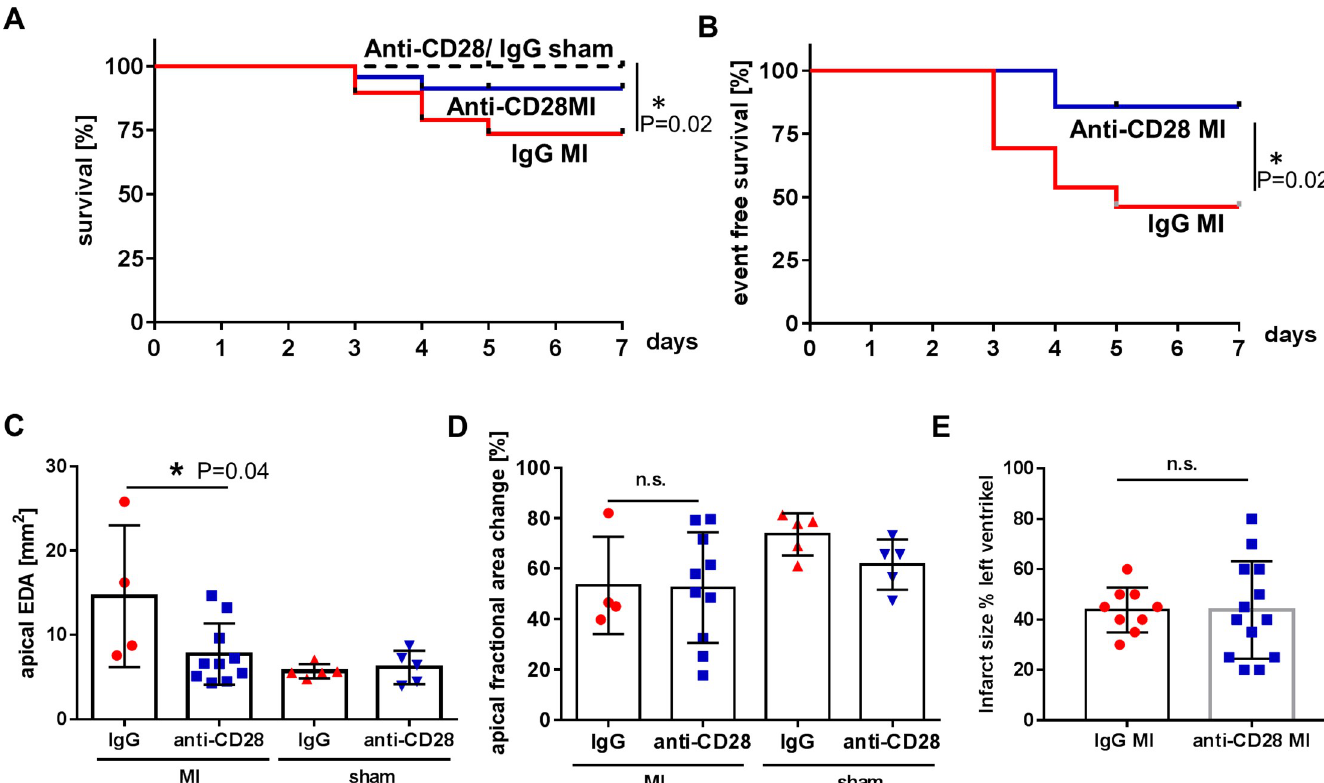
Fig 2. Treatment with anti-CD28 mAb E18 significantly enhanced survival compared to IgG control treatment (C: n = 19 IgG MI, n = 23 anti-CD28 MI, n = 11 IgG sham, n = 10 anti-CD28 sham, P < 0.05, Logrank Test, A). The rupture rate within the 7 days study was significantly lower in anti-CD28 treated animals (n = 19 IgG MI, n = 23 anti-CD28 MI, P < 0.05, Logrank Test, B). The end-diastolic area was significantly smaller in anti-CD28 treated animals (n = 4 IgG MI, n = 10 anti-CD28 MI, n = 5 IgG sham, n = 5 anti-CD28 sham, � p < 0.05, ANOVA, means ± SEM, C), whereas fractional area change (n = 4 IgG MI, n = 10 anti-CD28 MI, n = 5 IgG sham, n = 5 anti-CD28 sham, means ± SEM, D) and infarct size (determined by histology on day 5) (n = 9 IgG MI, n = 13 anti-CD28 MI, means ± SEM, E) were not